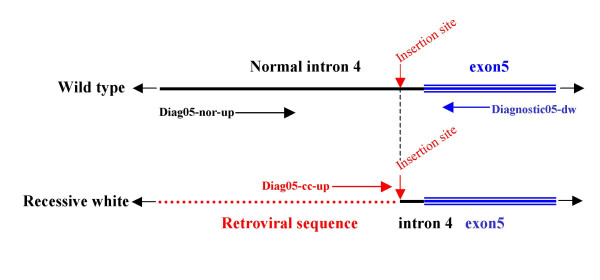
Principle of the PCR diagnostic test for the molecular identification of the insertional mutation in intron 4 of the chicken TYR gene. Two fragments may be obtained: 481 bp between Diag05-nor-up and Diagnostic05-dw for normal C*N allele, and 345 bp between Diag05-cc-up and Diagnostic05-dw for the C*C allele.